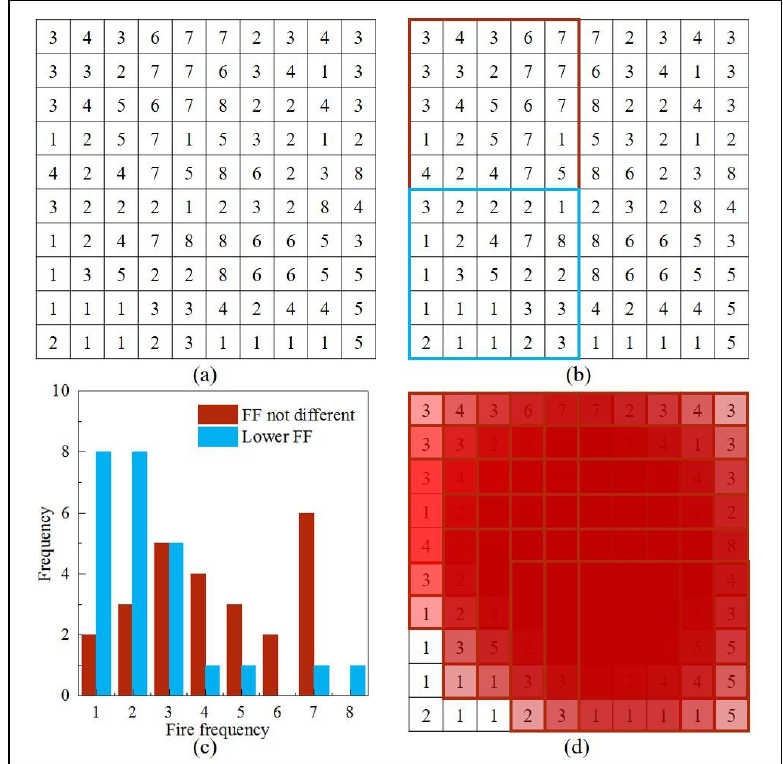
Figure 2. The Moving Window (MW) method of detecting edge effected regions (EER) with reduced fire frequency (RFF). ( a ) A hypothetical 10 × 10 grid landscape; the number in each grid represents the FF as the number of fires per 100 years. ( b ) Two representative 5 × 5 MWs: MW 1,1 outlined in red and MW 6,1 outlined in blue. ( c ) Frequency histograms of the FFs in the two MWs outlined in ( b ). The red MW has a mean FF above the threshold and, thus, does not contain EER. The blue MW has a mean FF below the threshold and, thus, does contain EER. ( d ) All 5 × 5 MWs which do not contain an EER with RFF are shaded red; the more such MWs a grid is present in results in the grid becoming shaded progressively darker red. The five individual grids in the lower left of the map were identified as EER with RFF as they were only present in MWs that did not contain an EER with RFF. Fifth, the mean and standard deviation of all FF MW measures in the GFF map are both